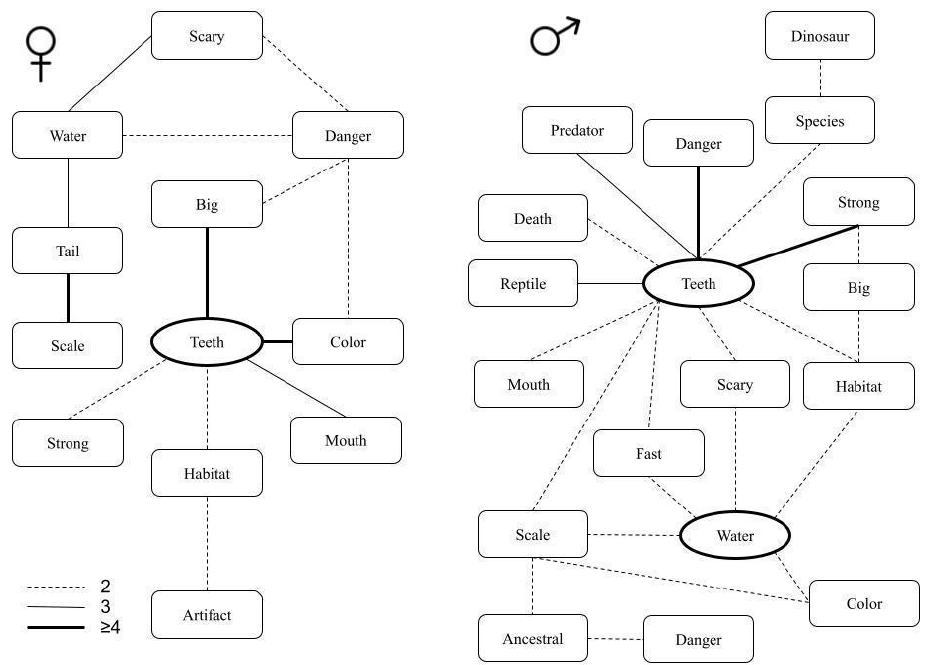
Figure 5. Tree with the elements of the social representation of crocodile (female vs. male participants).